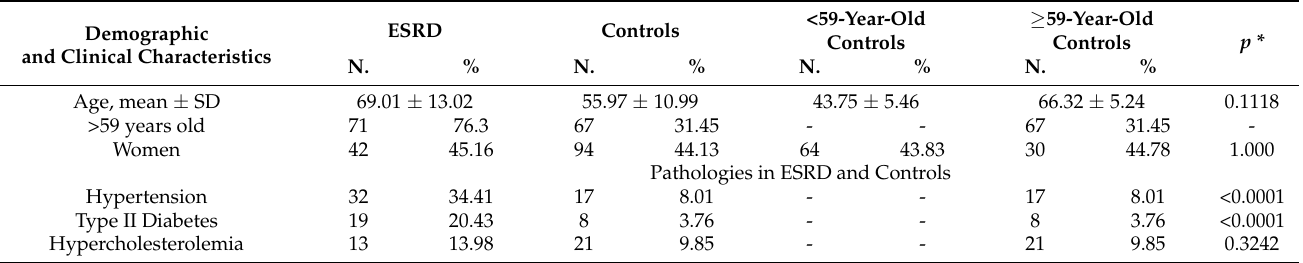
Table 1. Demographic and clinical characteristics of 93 patients with end-stage renal disease (ESRD) and 213 control